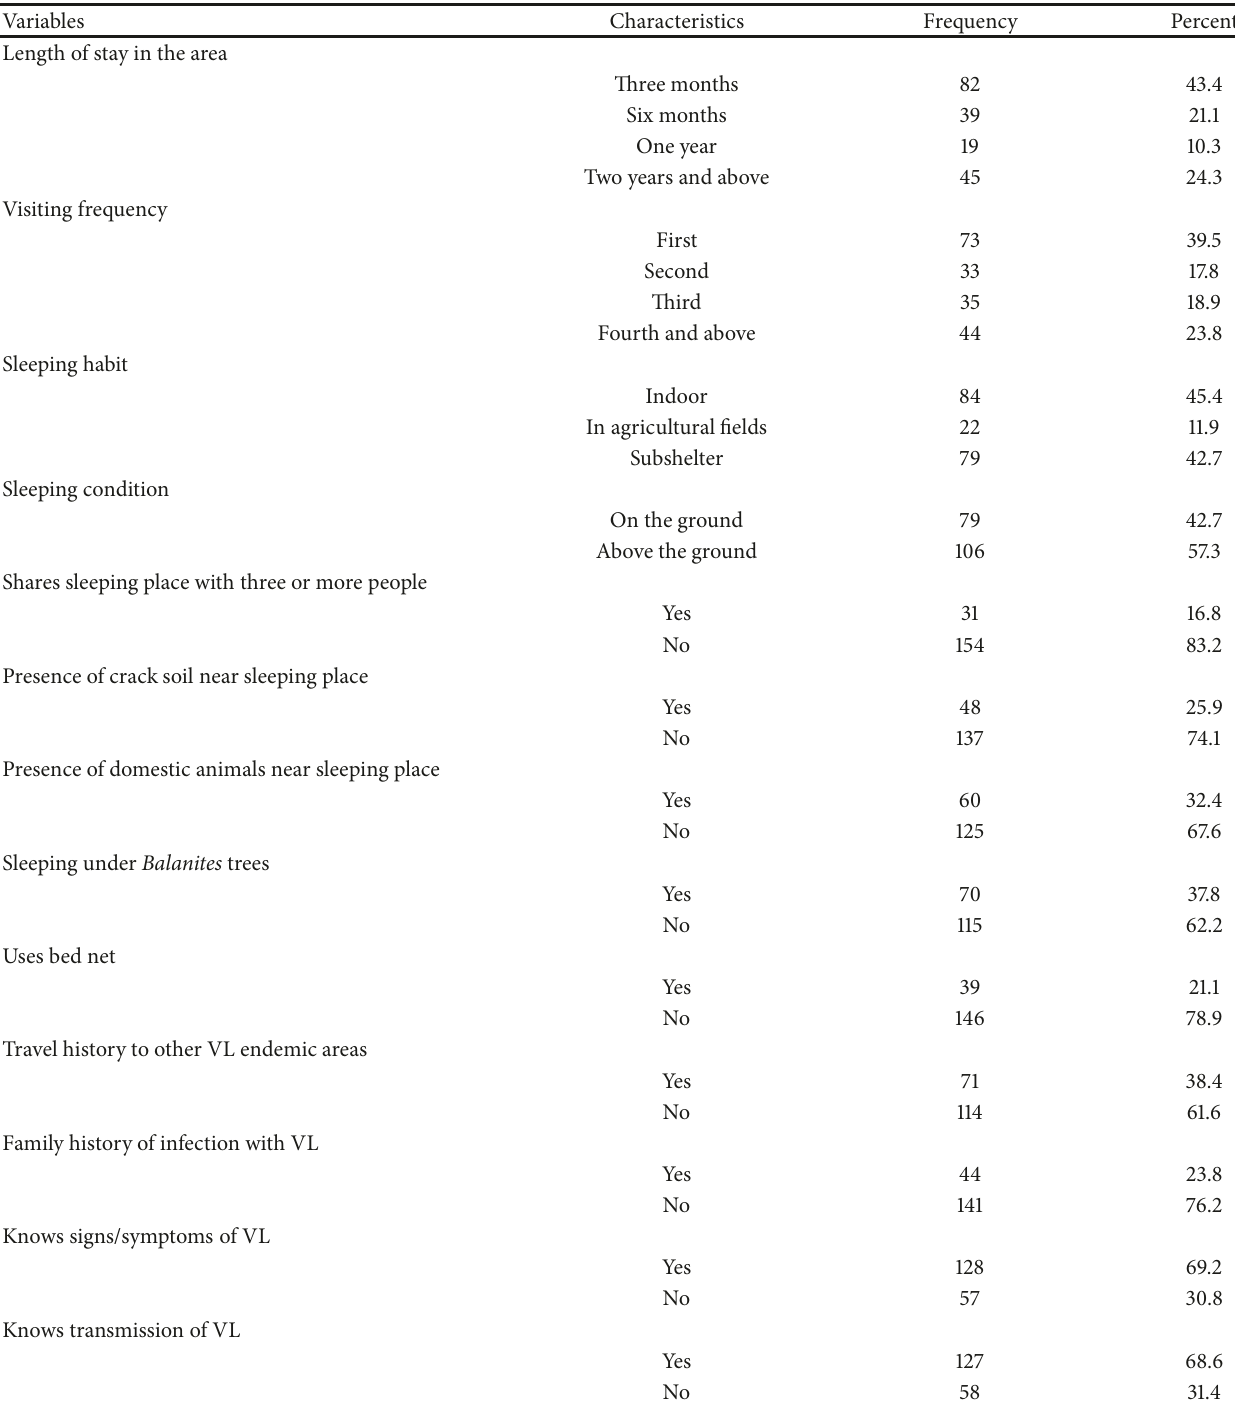
Table 2: Frequencies and percentages of possible risk factors for seroprevalence of asymptomatic Leishmania donovani .